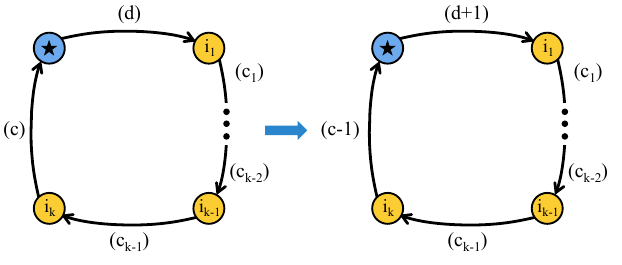
Figure 19. Mutation of a superpotential term with a 2-path that goes through the mutated node but does not generate a meson.